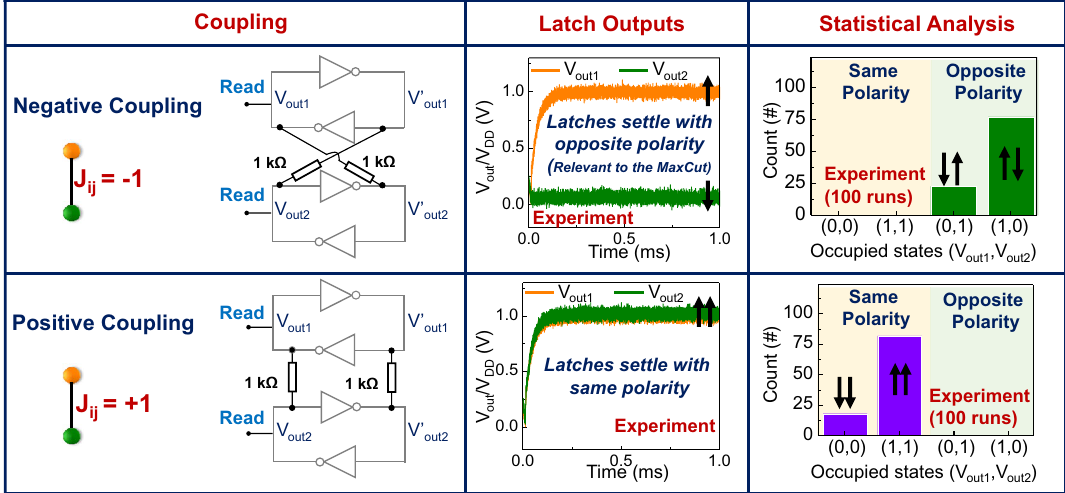
Figure 2. Coupling of two CMOS latch-based artificial Ising spins. Negative (J ij = − 1) and positive coupling (J ij = + 1) among the latches. The latch outputs (at the read terminal) always settle to the opposite (same) polarity when the negatively (positively) coupled, respectively, when the system is powered up. It is noted though that the exact output [i.e., whether V out1 or V out2 settle to 1 (= V DD ) or 0 (= 0 V)] shows probabilistic behavior.